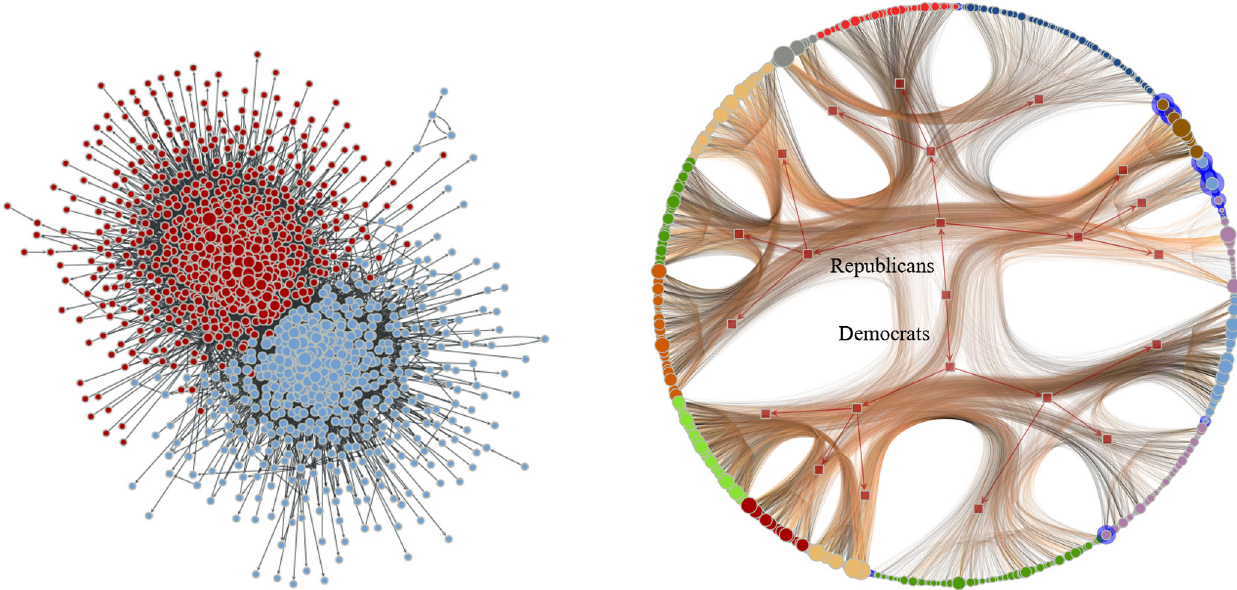
FIG. 5. The political blog network of Adamic and Glance [67]. Left: Topmost partition of the hierarchy inferred with the nested model. Right: The same network, using a circular layout, with edge bundling following the inferred hierarchy [68] (indicated also by the square nodes and the node colors). The size of the nodes corresponds to the total degree, and the edge color indicates its direction (from dark to light). Nodes marked with a blue halo were incorrectly classified at the topmost level, according to the accepted partition in Ref.